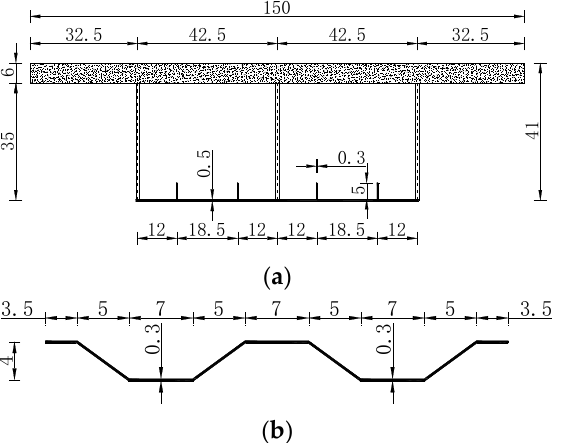
Figure 5. Model beam size (unit: cm): ( a ) section size; ( b ) dimension of the corrugated steel web.